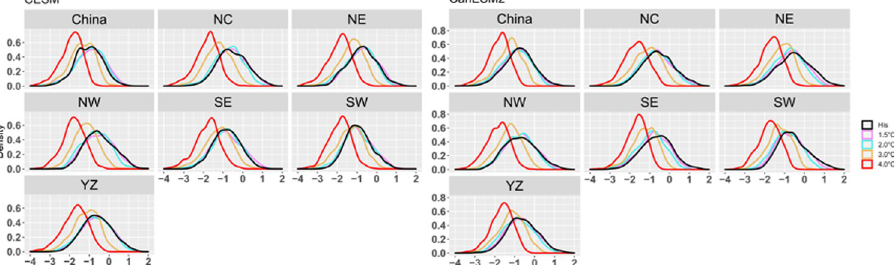
Fig 4. PDF of SDHI index for the China region and different subregions in a historical period and different future warming scenarios.